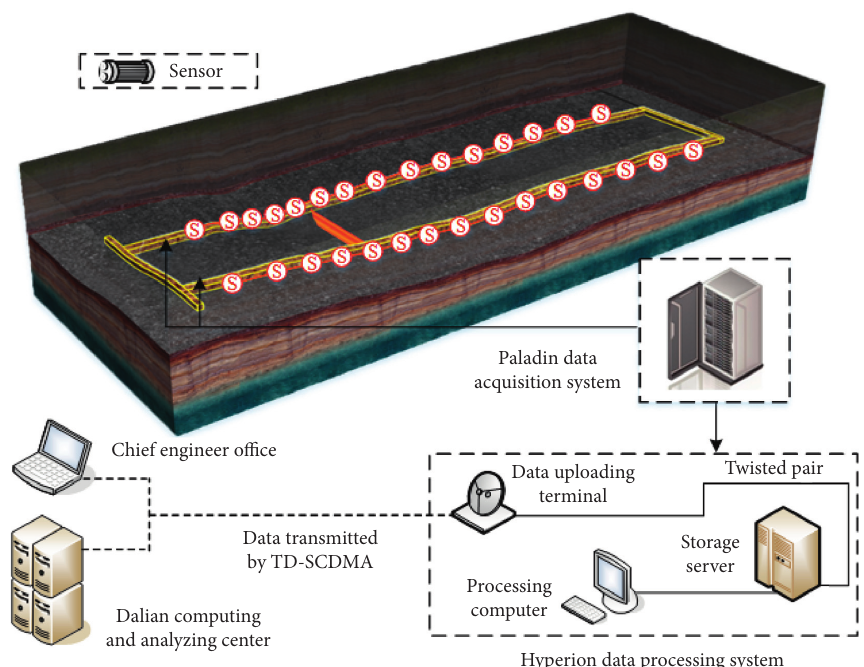
Figure 2: The topological structure of the microseismic monitoring system.